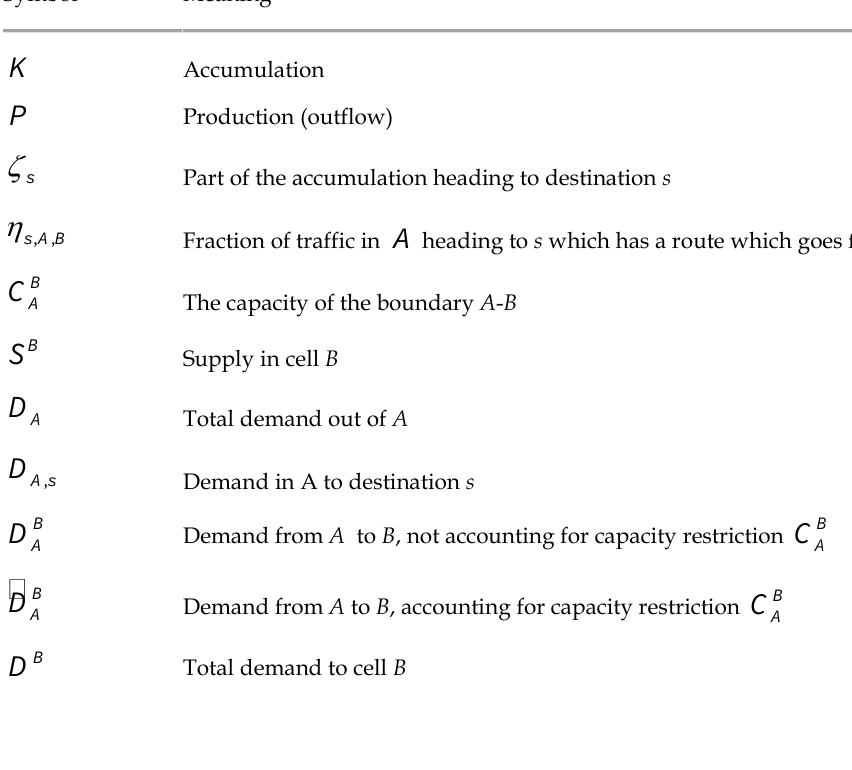
Table 1. Variables and their meaning; A and B refer to